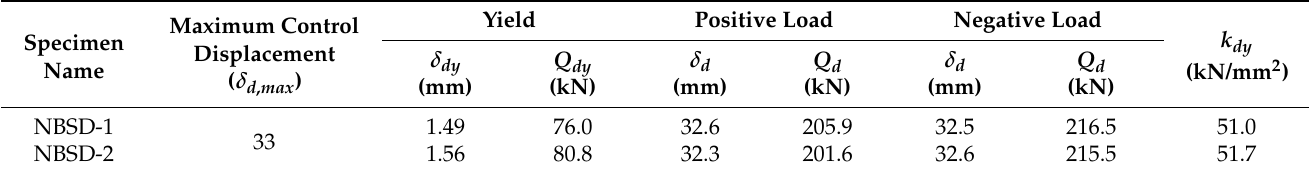
Figure 7. Images of the specimens at the maximum control displacement of 33 mm. Table 2. Test results obtained from the NBSD